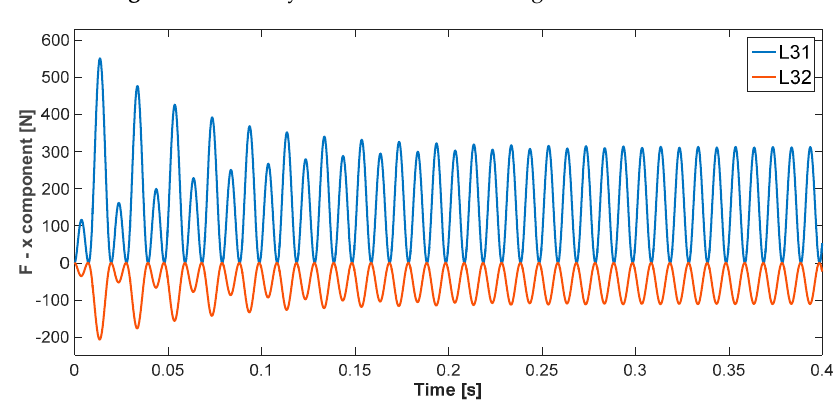
Figure 7. Electrodynamic forces on earthing knifes L21 and L22.